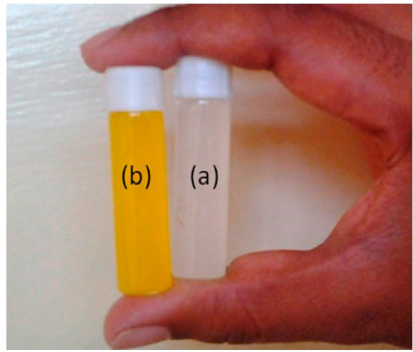
Figure 5. ( a ) Aqueous dispersions of NGs and ( b ) curcumin-loaded NGs. (Reproduced